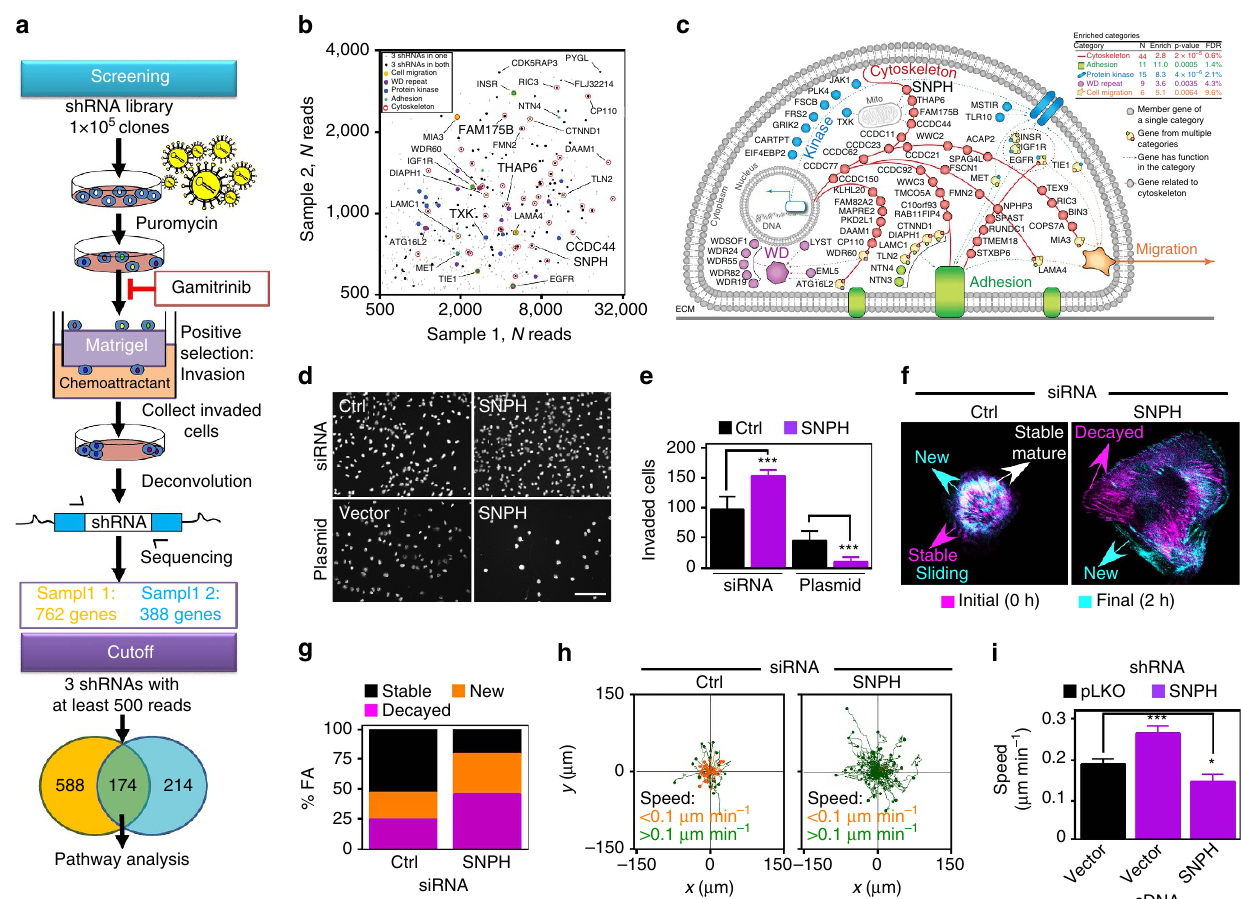
Figure 1 | SNPH regulation of tumour cell motility. ( a ) Schematic diagram of the genome-wide shRNA screening to identify novel mitochondrial regulators of tumour cell invasion modulated by Gamitrinib. ( b , c ) Bioinformatics analysis of mitochondrial regulators of tumour cell invasion modulated by Gamitrinib. ( d , e ) PC3 cells transfected with control siRNA (Ctrl) or SNPH-directed siRNA (top) or vector or SNPH cDNA (bottom) were analysed for invasion across Matrigel-coated inserts. Representative micrographs of DAPI-stained cells ( d ) and quantification of invaded cells ( e ). Data are represented as mean ± s.e.m. ( n ¼ 3). *** P ¼ 0.0006– o 0.0001 by Student’s t test. Scale bar, 200 m m. ( f ) LN229 cells labelled with Talin-RFP and transfected with control (Ctrl) or SNPH-directed siRNA were analysed for FA complex dynamics by time lapse microscopy. Representative merged frames at 0h (magenta) and 2h (cyan) are shown. Scale bar, 5 m m. ( g ) FA complex dynamics in LN229 cells transfected with control siRNA or SNPH-directed siRNA ( n ¼ 380). ( h ) LN229 cells were transfected with the indicated siRNAs and analysed for 2D chemotaxis by time-lapse video microscopy. Colour-identified cutoff velocities of cell motility are indicated. Each tracing corresponds to an individual cell. Sample sizes were Ctrl ( n ¼ 60), SNPH ( n ¼ 89). ( i ) shRNA-transduced PC3 cells were reconstituted with vector or SNPH cDNA and analysed for cell motility in a 2D chemotaxis chamber with quantification of speed of cell migration. Data are represented as mean ± s.e.m. Sample sizes were: pLKO,Vector ( n ¼ 46), SNPHsh,Vector ( n ¼ 48), SNPHsh,SNPHcDNA ( n ¼ 46). * P ¼ 0.0209; *** P ¼ 0.0007 by one-way ANOVA and Bonferroni’s